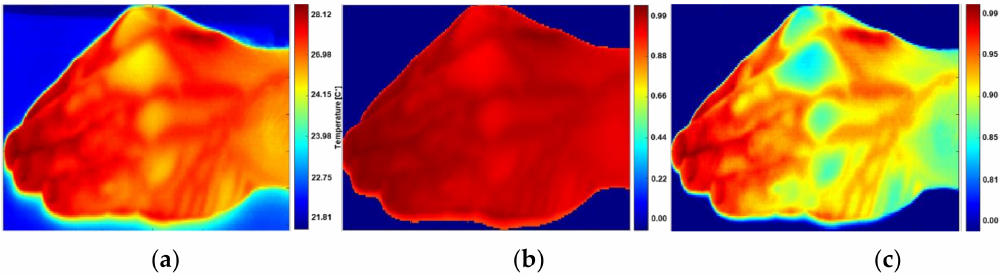
Figure 13. Normalization and segmentation obtained in Section 2.4. ( a ) False-color image with thermal interferences, ( b ) IR image after thresholding step at 0.8. The thresholding leads to a homogeneous image background. ( c ) Segmentation results with color contrast on the RoI, in which the false colors represent the temperature intensities.